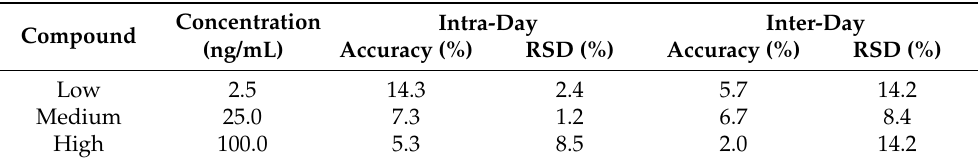
Table 5. Matrix effect and extraction recovery for the assay of Nef in the brain samples ( n = 6). Matrix Subclass IS Spike (ng/mL)